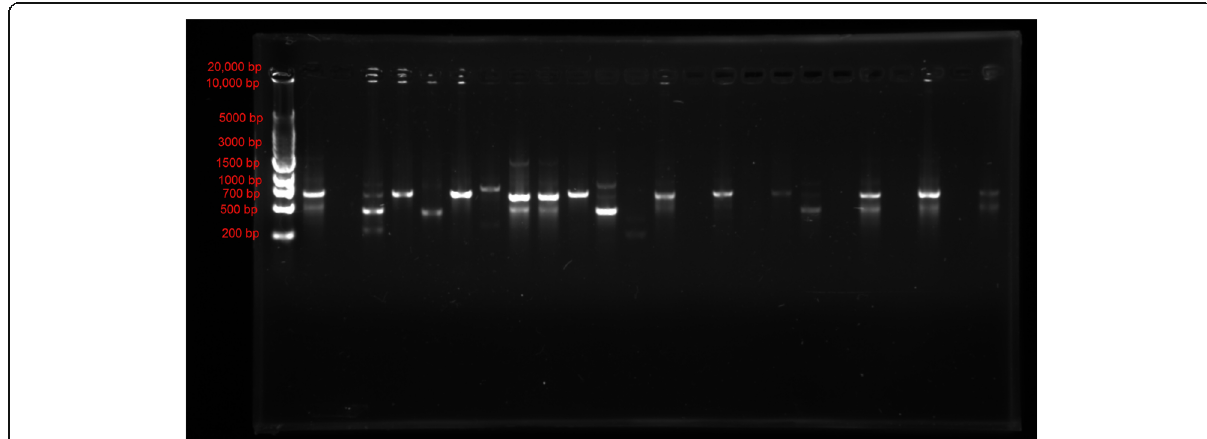
Fig. 3 RAPD fingerprint of all isolates using OPL-14 as a random primer